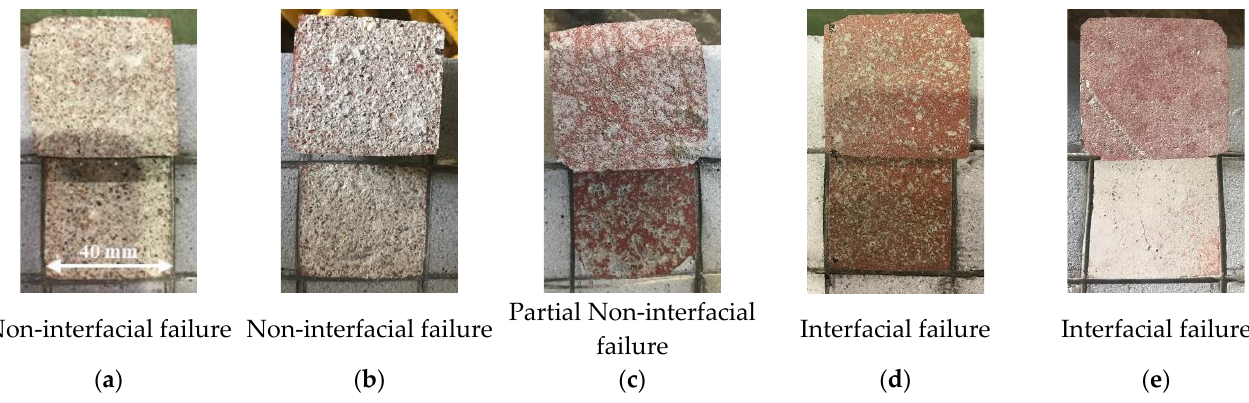
Figure 10. Failure modes. ( a ) Zinc; ( b ) Zinc/Al; ( c ) Al; ( d ) Cu/Zn; ( e ) Cu/Sn.